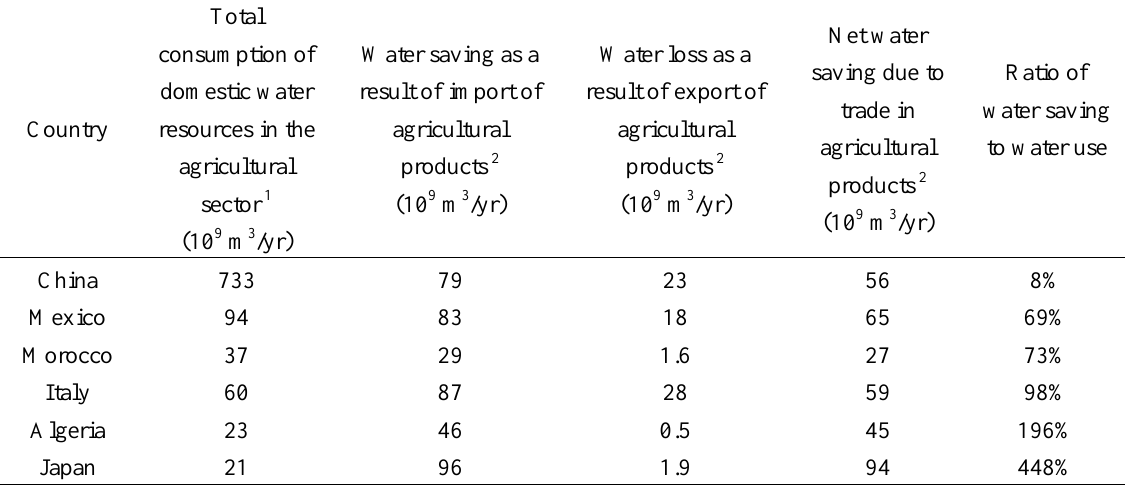
Table 1. Examples of nations with net water saving as a result of international trade in agricultural products (Period